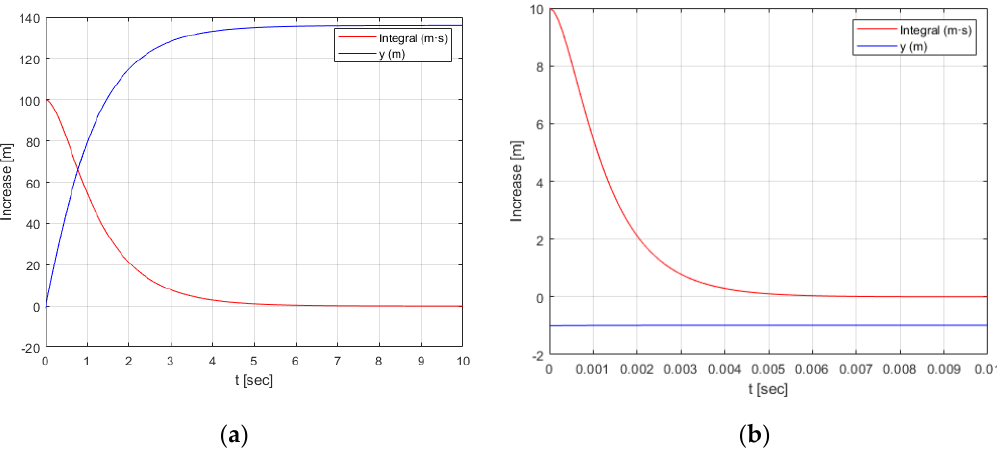
Figure 7. Results of simulation: ( a ) Plot when V is high and K 1 low; ( b ) Plot when V is low and K 1 high.